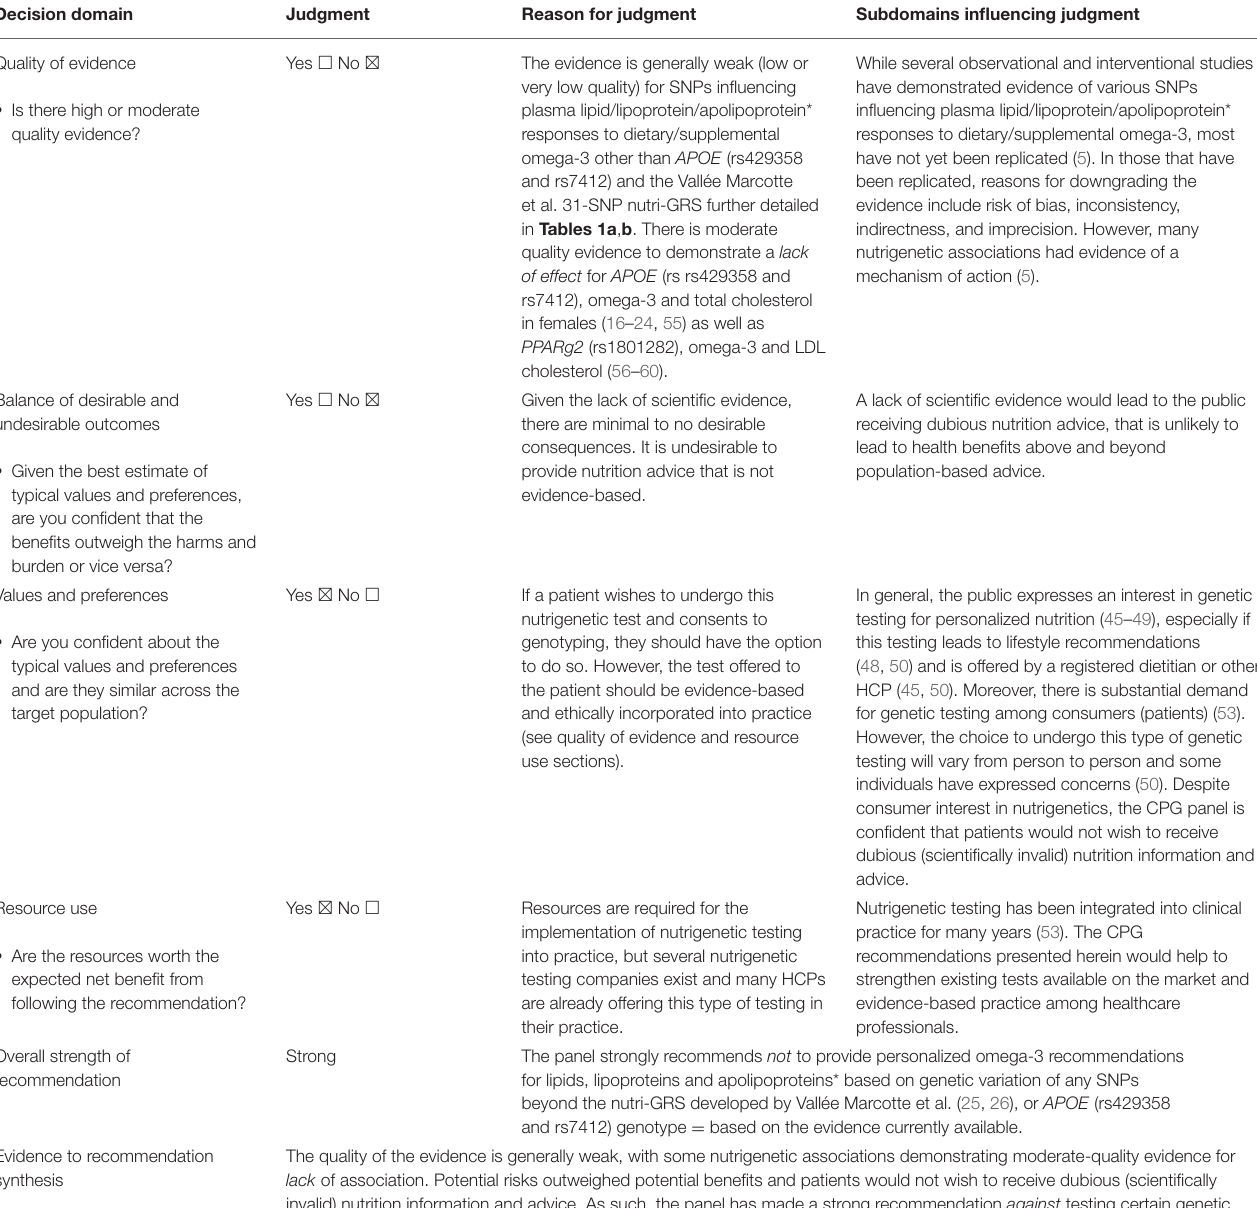
TABLE 1c | Genetic testing of variants for evaluating plasma lipid/lipoprotein/apolipoprotein* responses to dietary/supplemental omega-3 other than omega-3/TG responsiveness and APOE (rs429358 and rs7412) or the Vallée Marcotte et al. 31-SNP nutri-GRS. Decision